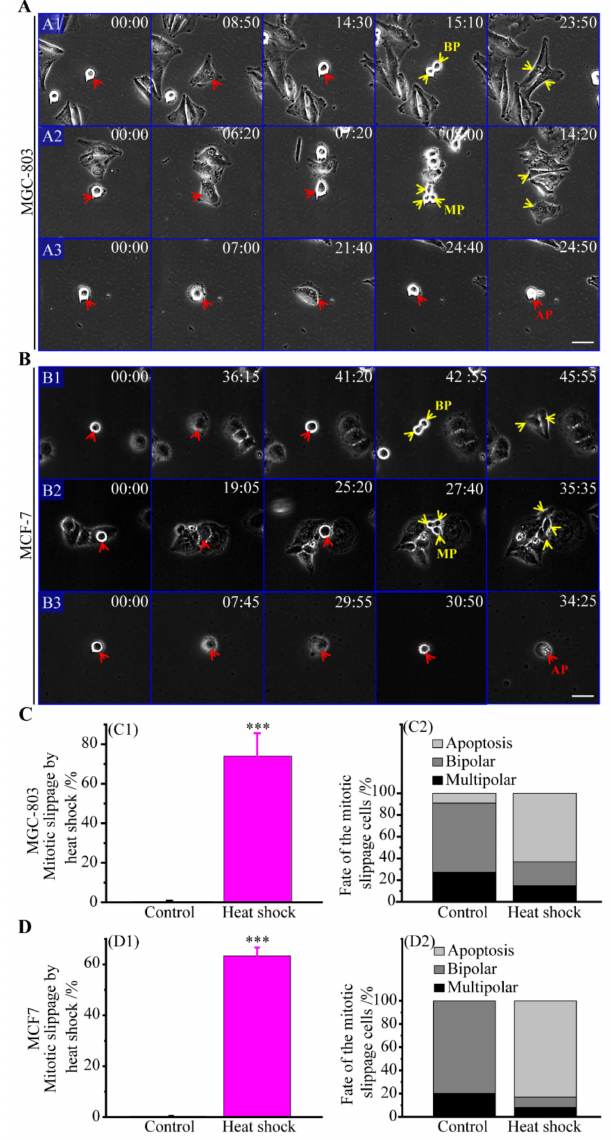
Figure 2. Mitotic slippage of cancer cells caused by heat stress and their cell fates. ( A ) Time-lapse images of MGC-803 cells; ( A1 ) bipolar division, ( A2 ) multipolar division, and ( A3 ) cell apoptosis of MGC-803 cells after mitotic slippage induced by heat stress, scale bar: 50 µ m. ( B ) Time-lapse images of MCF-7 cells; ( B1 ) bipolar division, ( B2 ) multipolar division, and ( B3 ) cell apoptosis of MCF-7 cells after mitotic slippage induced by heat stress, scale bar: 40 µ m. ( C ) The mitotic slippage frequency of MGC-803 cells and their cell fates; ( C1 ) the frequency of MGC-803 cells with mitotic slippage (mean values ± SD are shown from three independent experiments); ( C2 ) MGC-803 cells fates with mitotic slippage; the ratios through the routes of bipolar divisions, multipolar divisions and cell apoptosis are 7:3:1 in the control and 67:45:191 in the heat shock group of MGC-803 cells, respectively. ( D ) The mitotic slippage frequency of MCF-7 cells and their cell fates; ( D1 ) the frequency of MCF-7 cells with mitotic slippage (mean values ± SD are shown from three independent experiments); ( D2 ) MCF-7 cells fates with mitotic slippage; the ratios through the routes of bipolar divisions, multipolar divisions and cell apoptosis are 4:1:0 in the control and 11:10:102 in the heat shock group of MCF-7 cells, respectively. BP (bipolar), MP (multipolar), and AP (apoptosis). p -value < 0.05 was considered statistically significant, *** p <